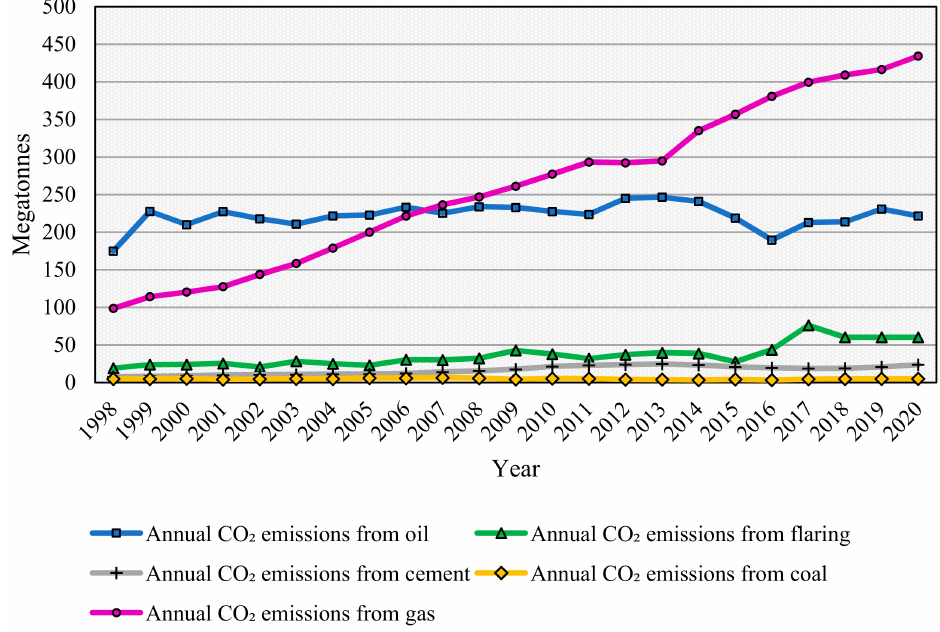
Figure 5. CO 2 emissions from various resources in Iran [40].